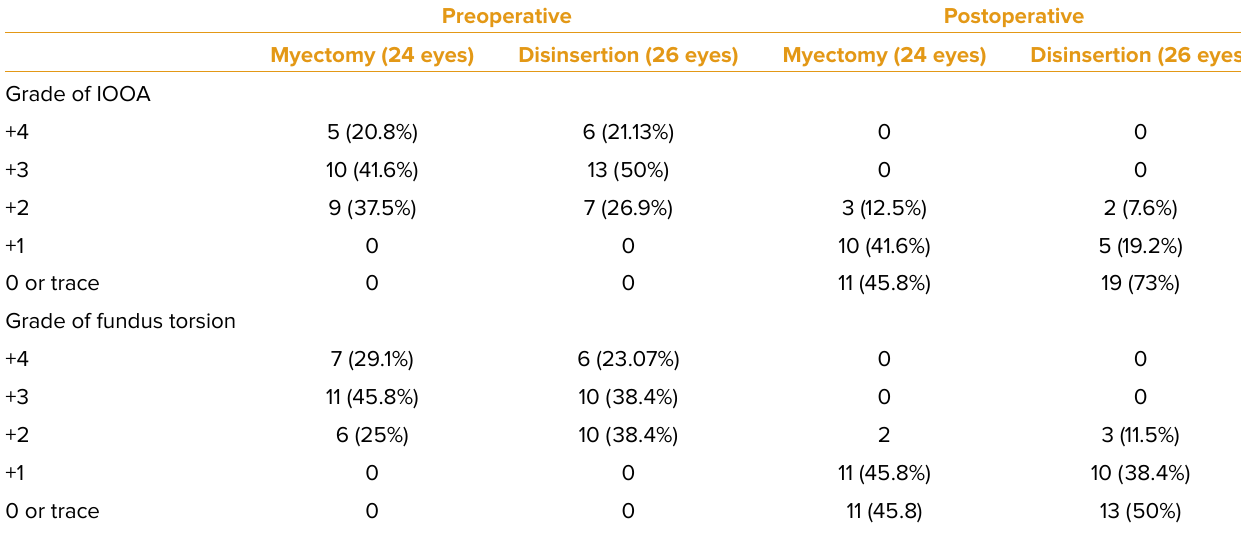
Table 2. Distribution of eyes with various grades of IOOA and fundus torsion in each group pre- and